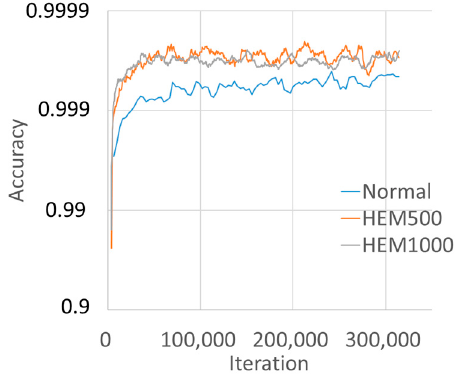
Figure 10. Moving average of Figure 9d.